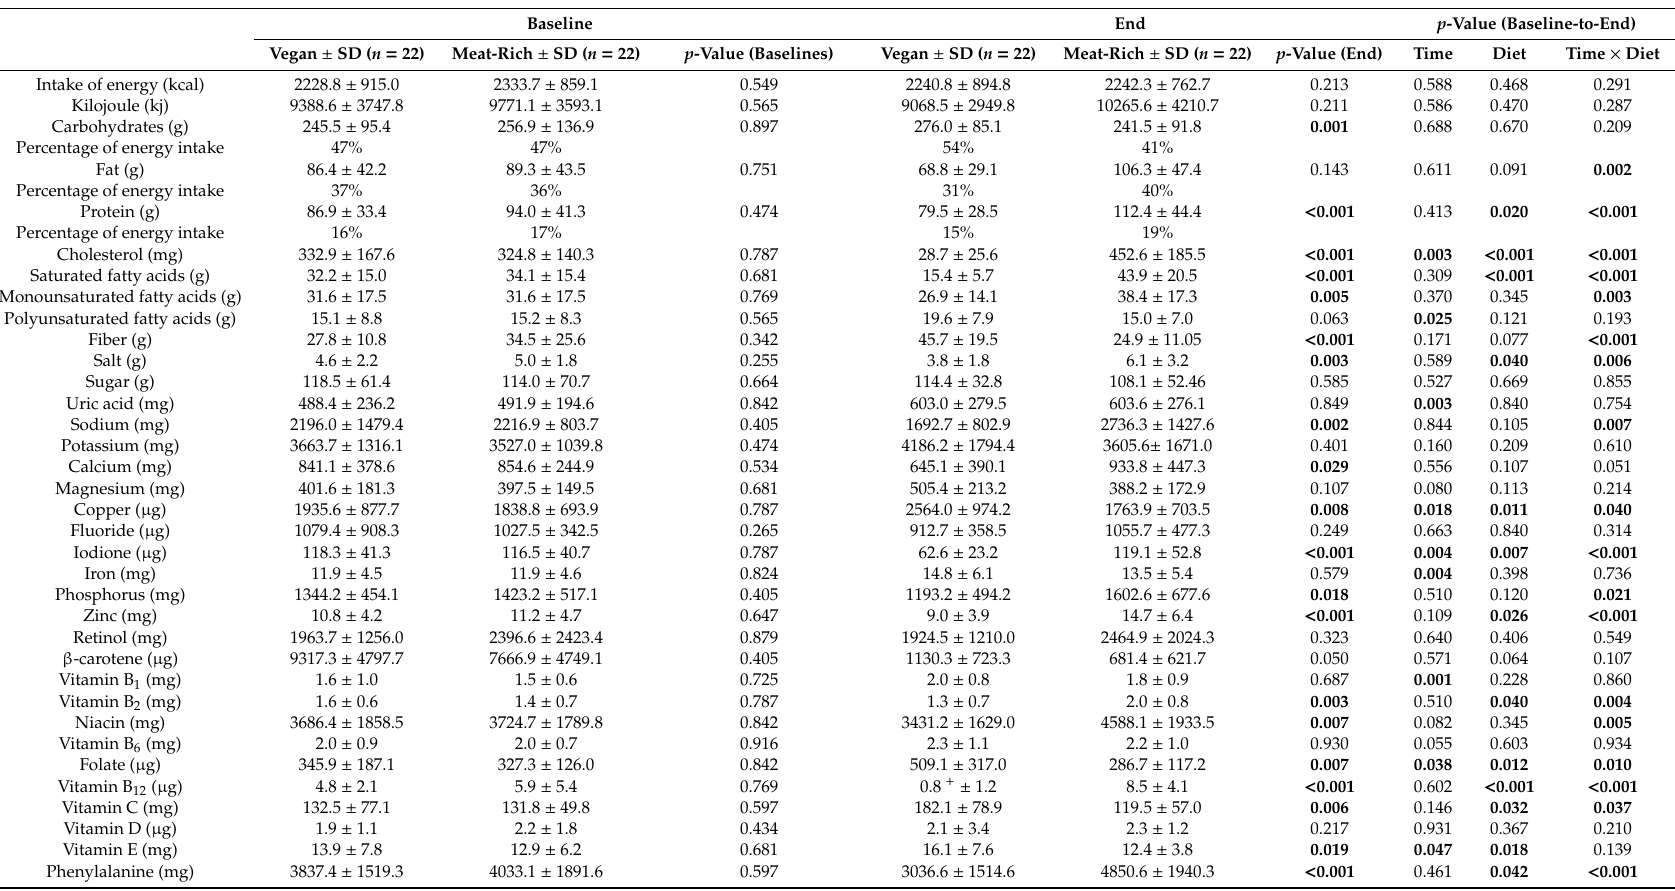
Table 5. Results of the nutritional protocols: comparison of mean of daily nutritional intake during four weeks of intervention. SD = Standard deviation; + due to food with added vitamin B 12 ; p -value (baselines) indicates comparison of values at baseline (results from t -test or MWU-test). p -value (end) indicates comparisons at the end of the study adjusted for baseline values (results from ANCOVA). p -value (baseline-to-end) indicates comparisons of changes from baseline to end of study (results from mixed ANOVA). Statistically significant results are bolded ( p < 0.05).